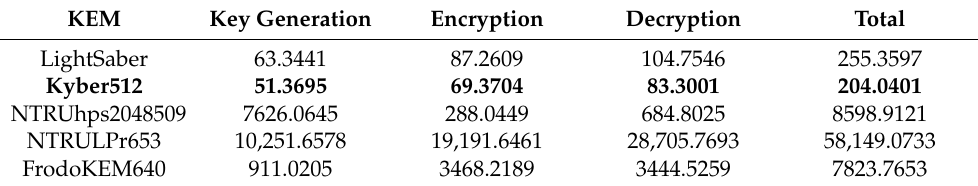
Table 4. The mean value of CPU usage, measuring the total number of milliseconds required to complete each of the operations. The standard deviation and 95% confidence interval (CI) for each of the operations can be seen in Tables 5–7. KEM Key Generation Encryption Decryption